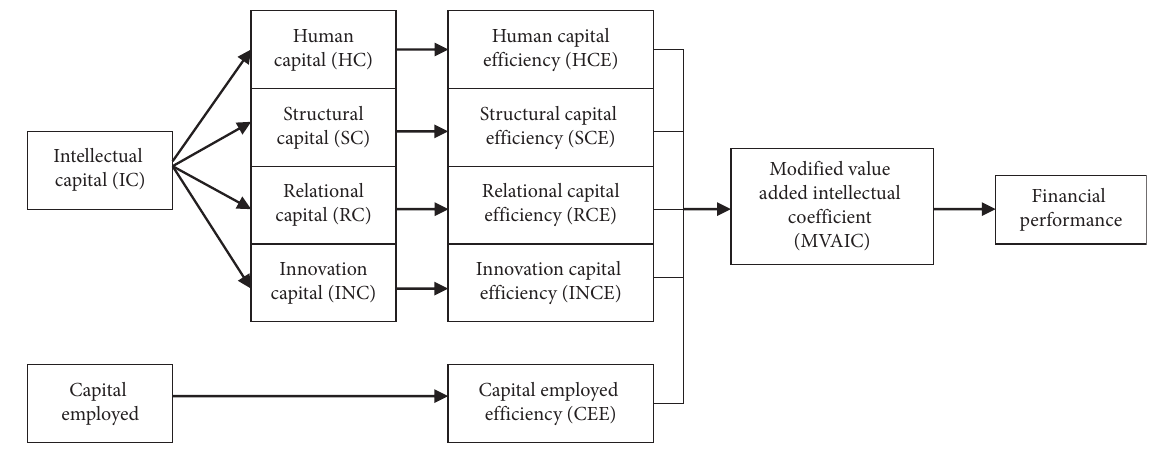
Figure 1: Conceptual